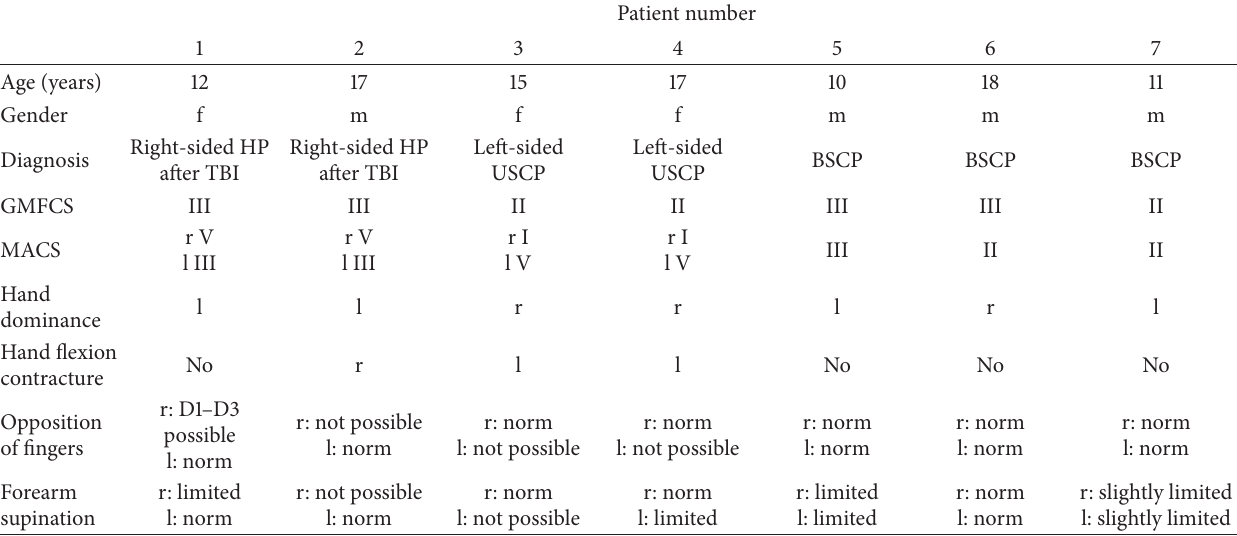
Table 1: Patients’ clinical data (r = right hand, l = left hand, HP = hemiparesis, USCP = unilateral spastic cerebral palsy, BSCP = bilateral cerebral palsy, TBI = traumatic brain injury, D1 = thumb, D2 = index finger, and D3 = middle finger).